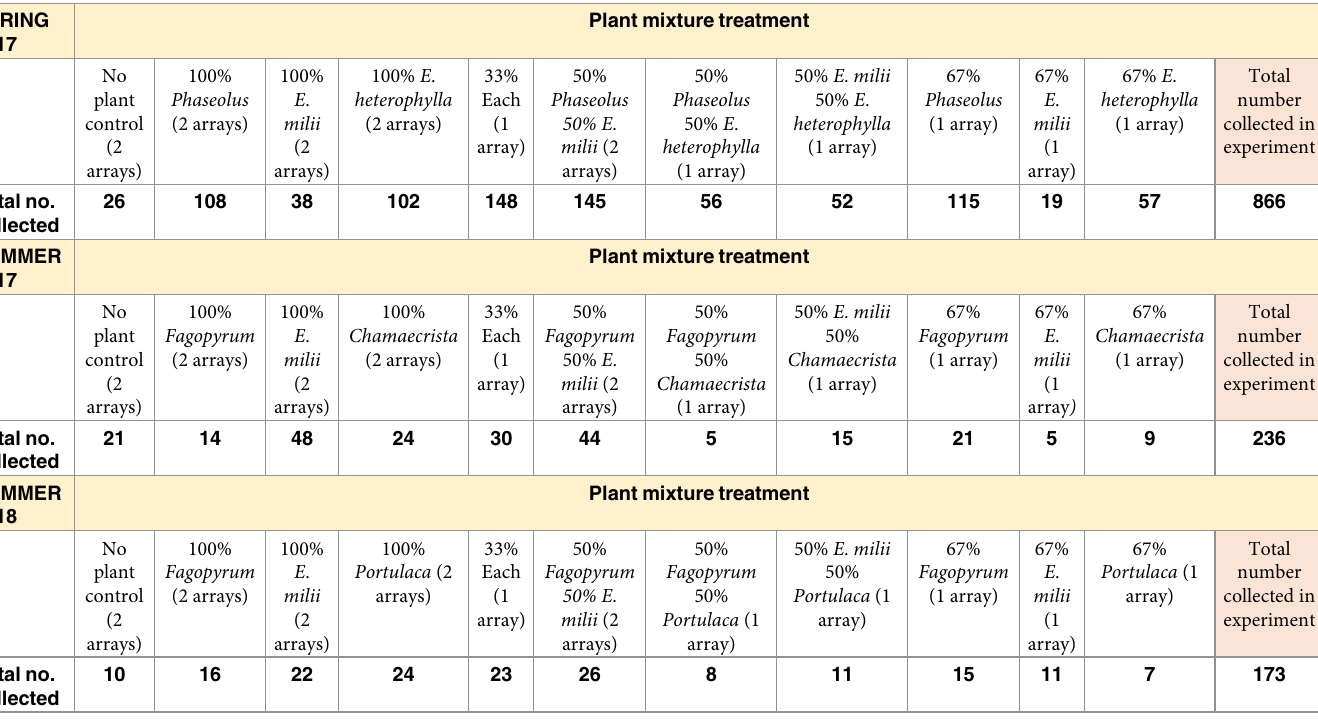
Table 5. Total numbers of Blattella asahinai collected from plant mixture treatments during each experiment. Total numbers of specimens collected is shown in right hand